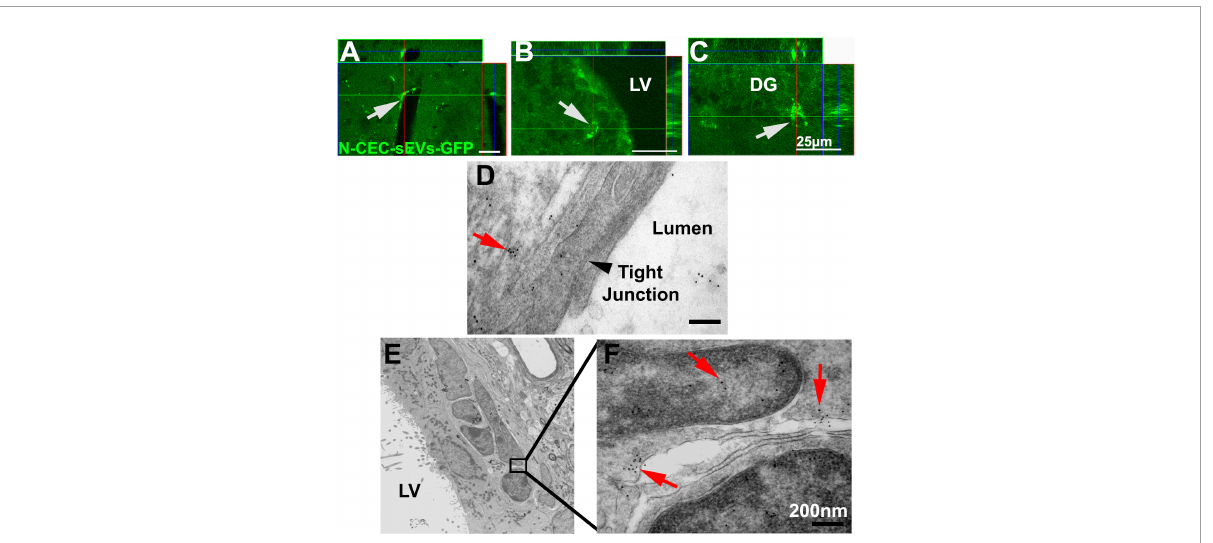
FIGURE7 N-CEC-sEVs intravenously administered cross the BBB and are internalized by NSCs. Representative confocal microscopic images show GFP signals (green, arrows) in cells lining cerebral vessels (A) and cells within the SVZ (B) and DG of hippocampus (C) after IV injection of N-CEC-sEVs-GFP. Representative TEM images (D–F) show GFP positive immunogold particles (red arrows) within endothelial cells that lining the cerebral blood vessel luminal surface (D) , where tight junction was intact (black arrowhead in D ). GFP positive immunogold particles (10 nm, E,F ) were within sEVs (red arrows) localized to cytoplasm and nucleus of SVZ cells. LV, lateral ventricle. Bars = 25 µ m in (A–C) . Bars = 200 nm in (D,F)